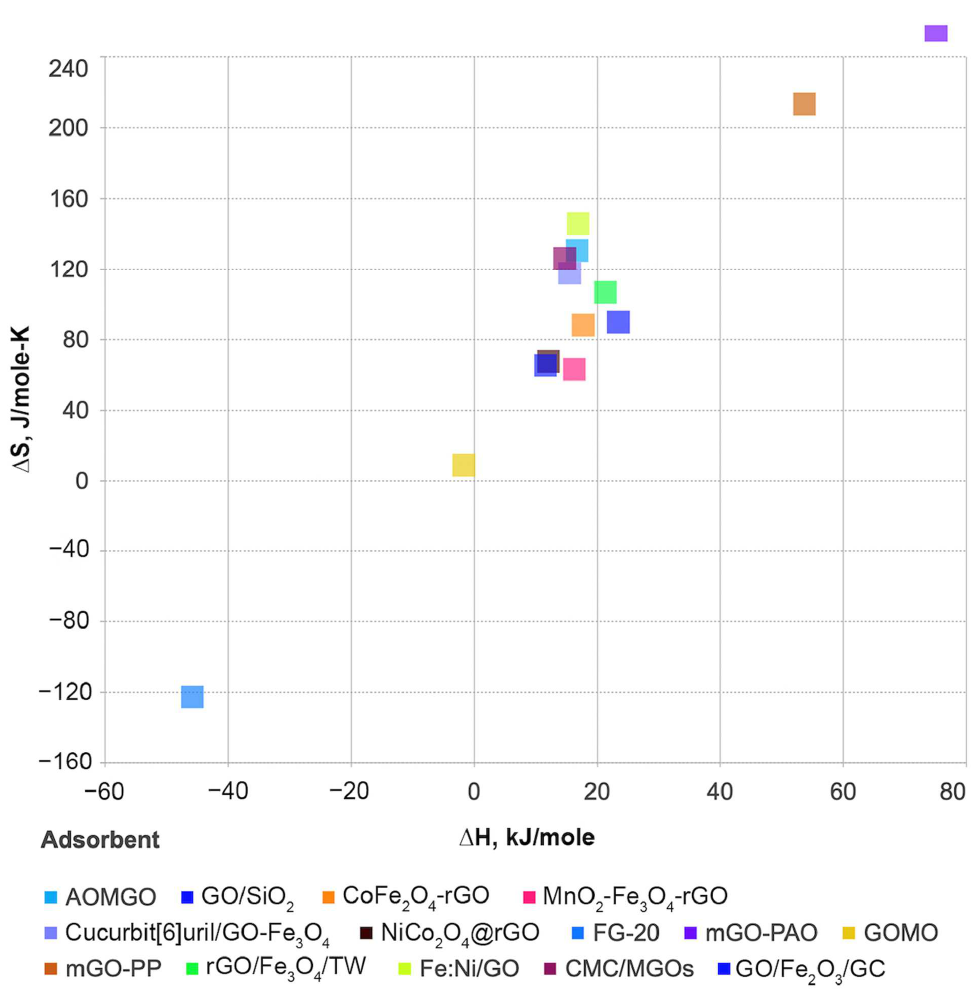
Figure 3. Enthalpy vs. Entropy compensation effect of GO-M hybrids on adsorption of uranium adsorbates. Data listed in Table 5.